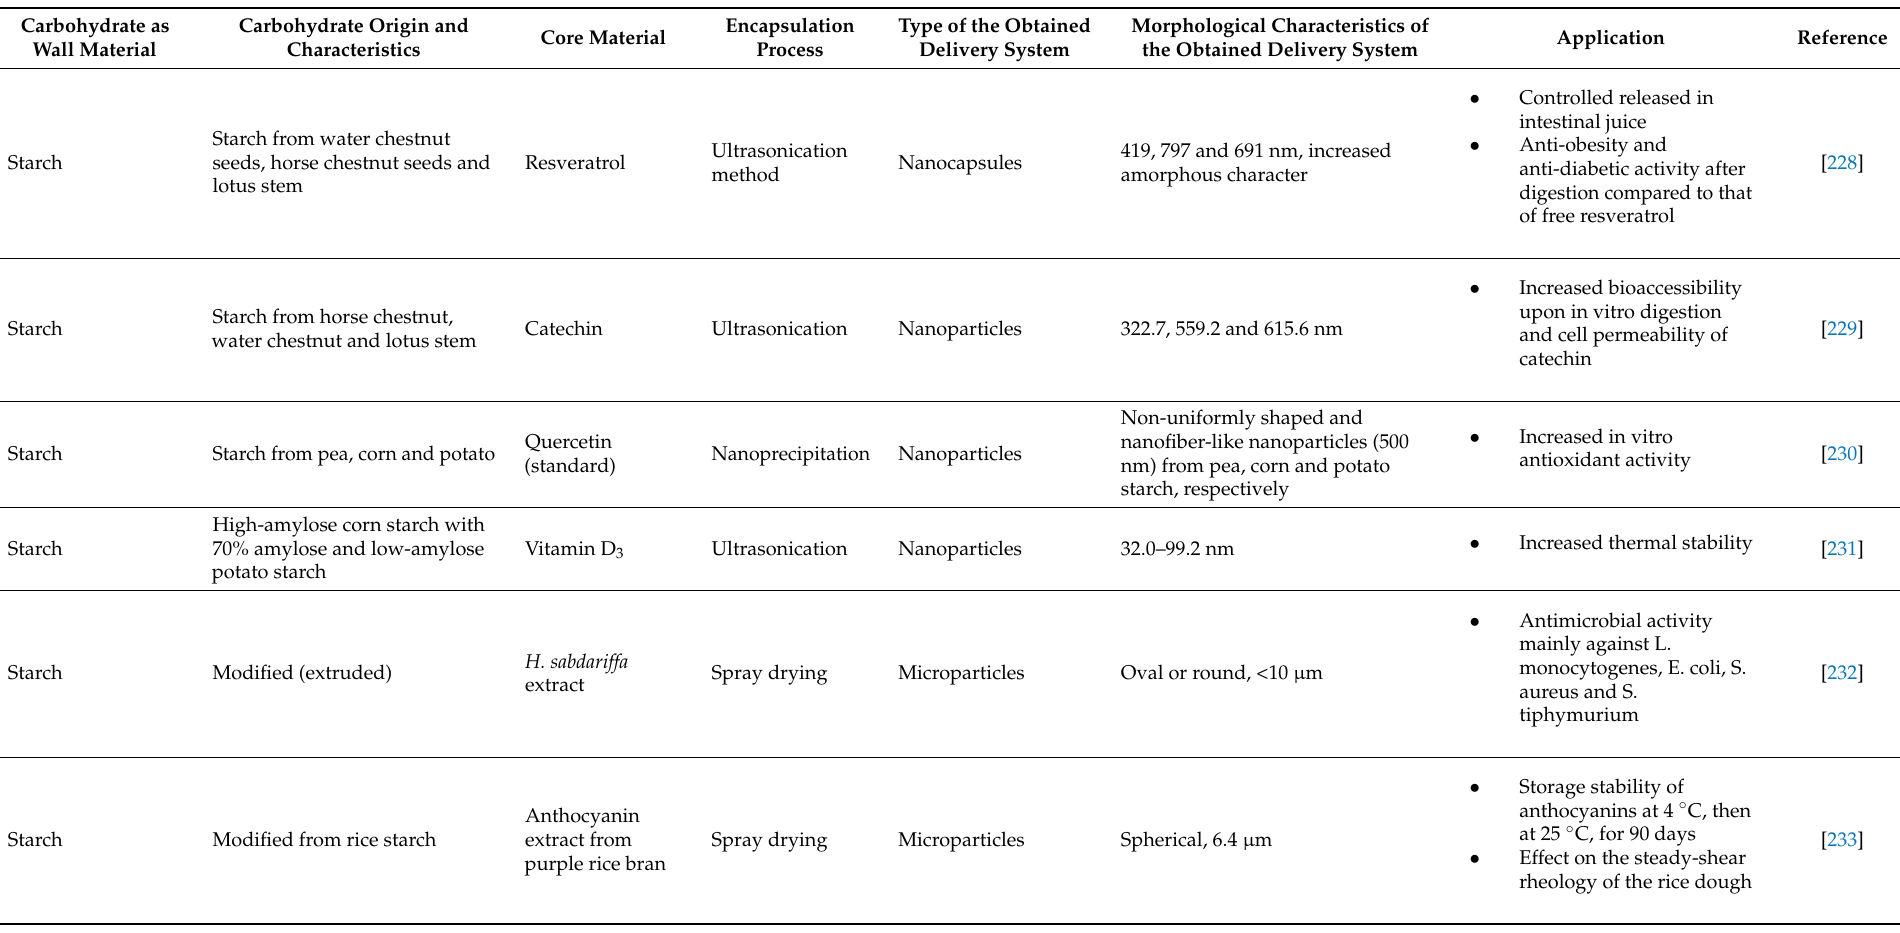
Table 2. Overview of different carbohydrates that have been used as wall materials for the encapsulation of various pure plant bioactive compounds, extracts and essential oils. Carbohydrate as Wall